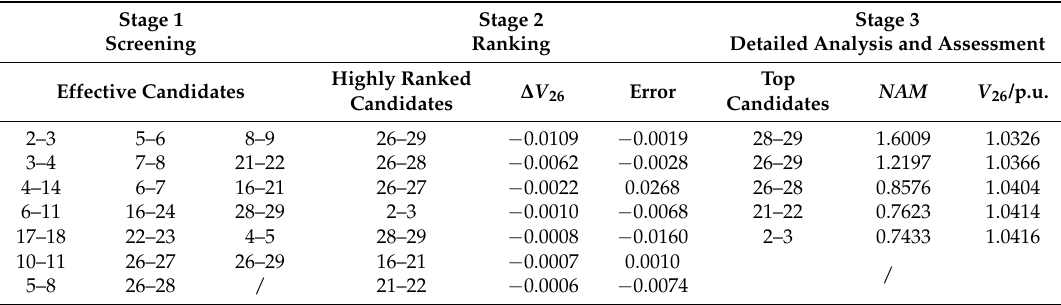
Table 1. Result of single lines switched